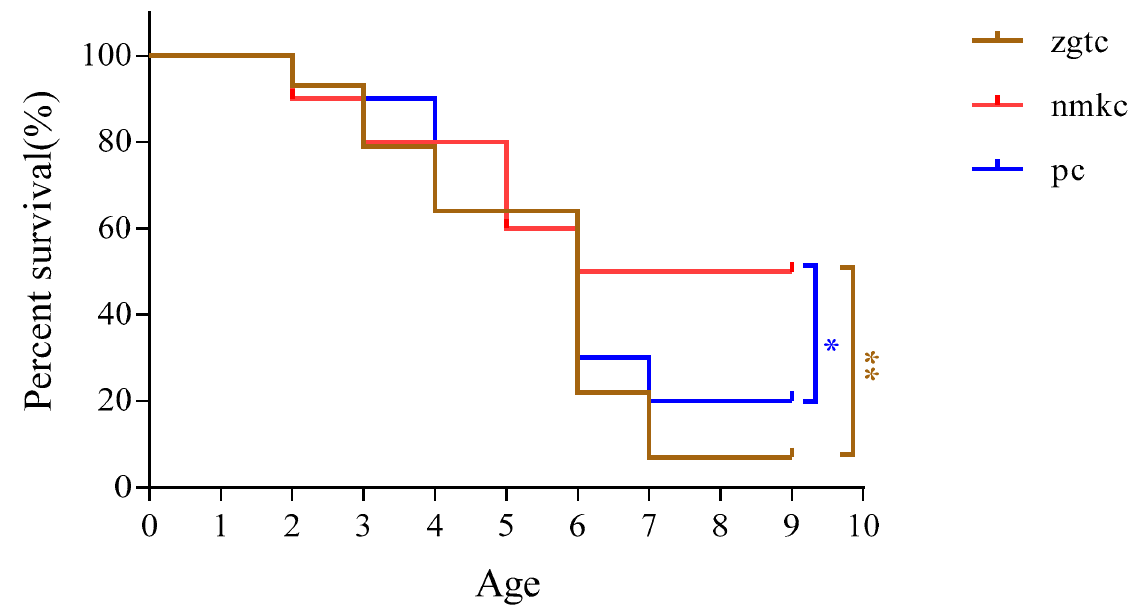
Figure 2. Survival rates of Daphniopsis tibetana from different origins. *: Have difference; **: Have a significant difference.